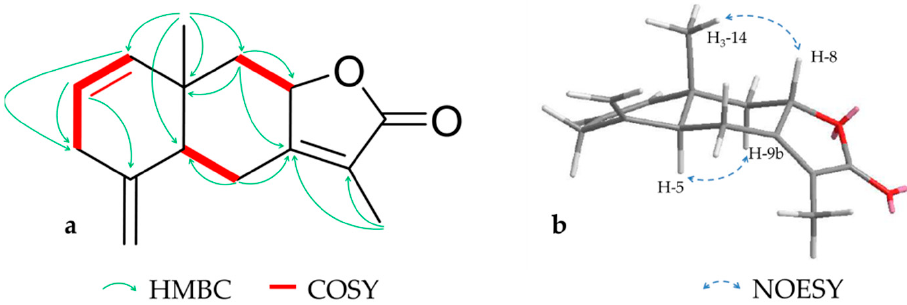
2.37) and -5 as well as between H-8 and H-14 revealed a 5S,8S,10S configuration as de-